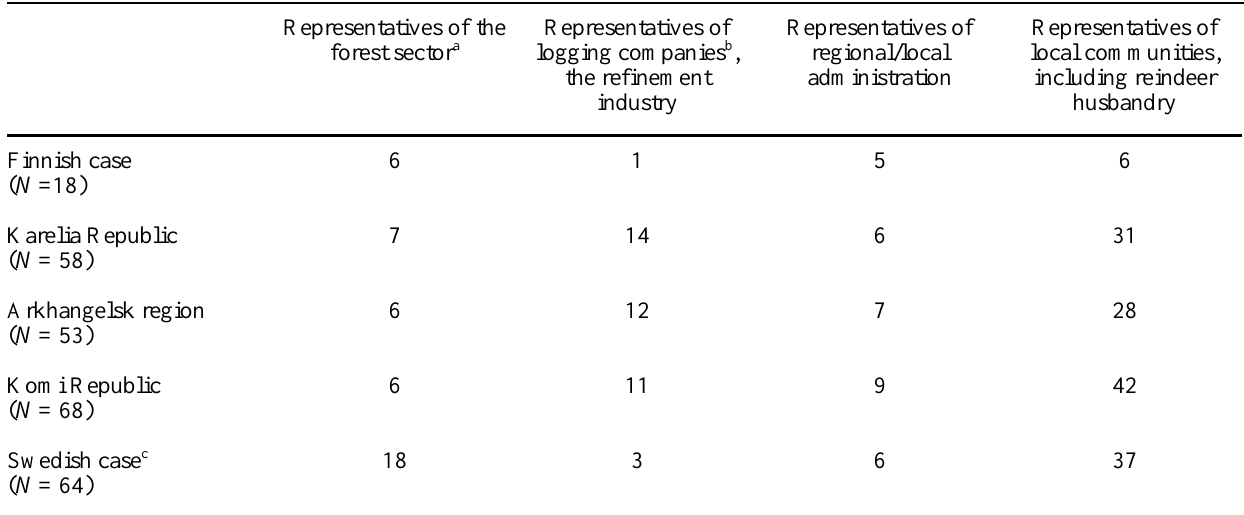
Table 1. Distribution of respondents among sectors and case studies